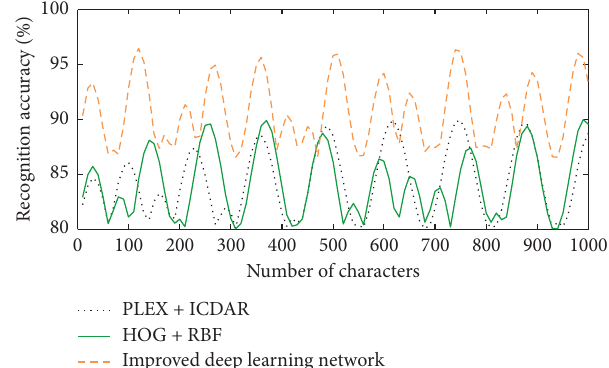
Figure 9: Experimental results of word recognition based on improved deep learning network